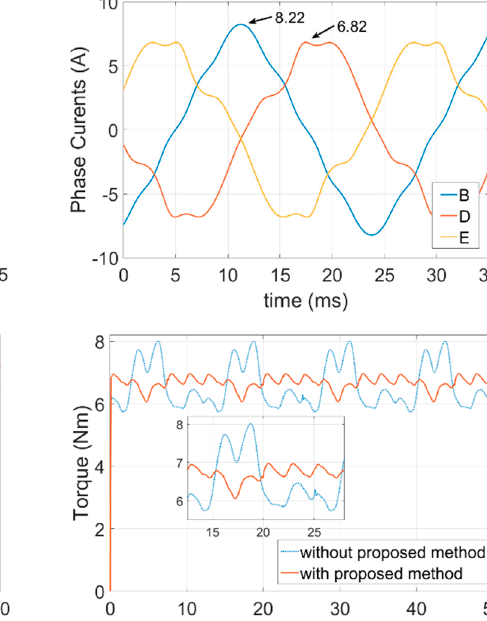
Figure 13. FEA torque waveforms for the fault-tolerant control currents of the ADPOC condition with and without the proposed method: ( a ) Only fundamental; ( b ) fundamental plus third har- monic.